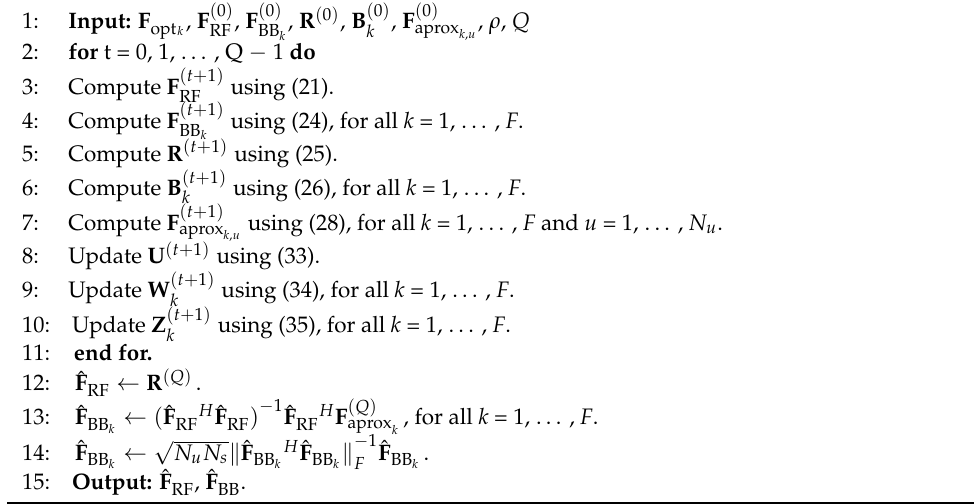
Table 1. General Iterative Hybrid Design